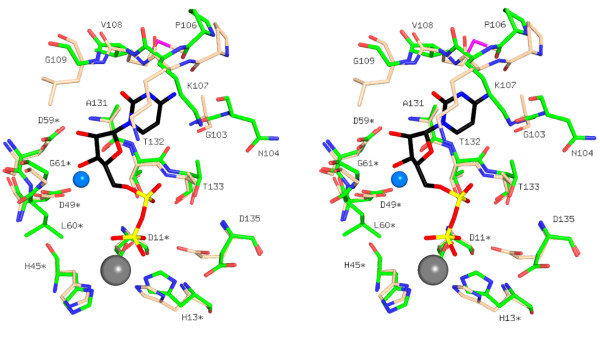
Stereo-view of the active site overlay of MsIspF and EcIspF. Residues from MsIspF are labeled and CDP-B is the depicted conformer. Protein atoms are colored: C of MsIspF green, C of EcIspF wheat, all N atoms blue, O atoms red, and Se atoms magenta. The marine sphere depicts the water molecule that contributes to solvent-mediated interactions between IspF and the ribose hydroxyls of CDP.